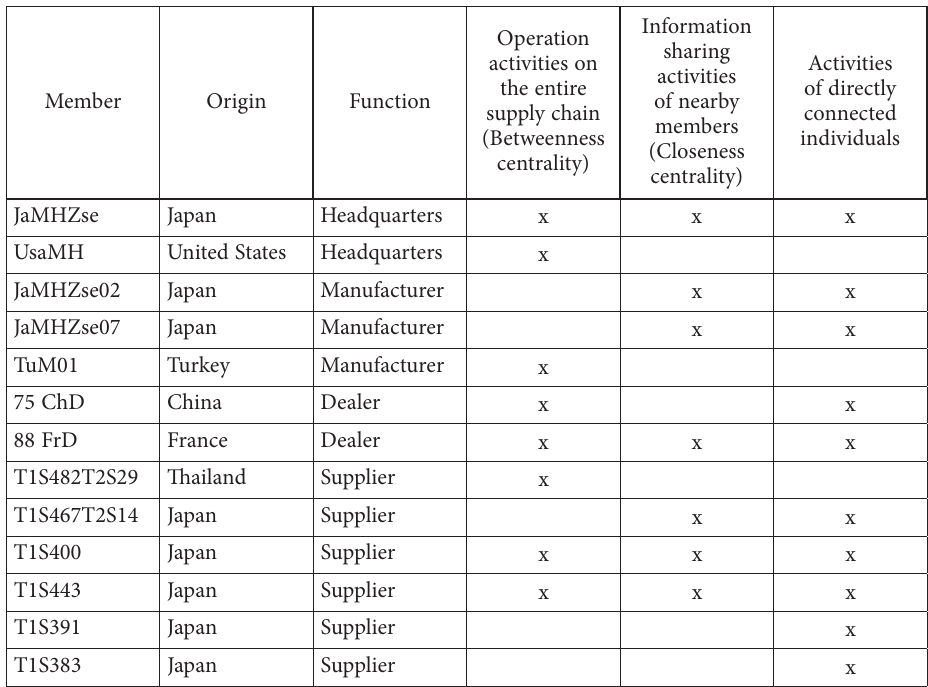
Table 7. Impact summary of key members in network (source: own study)